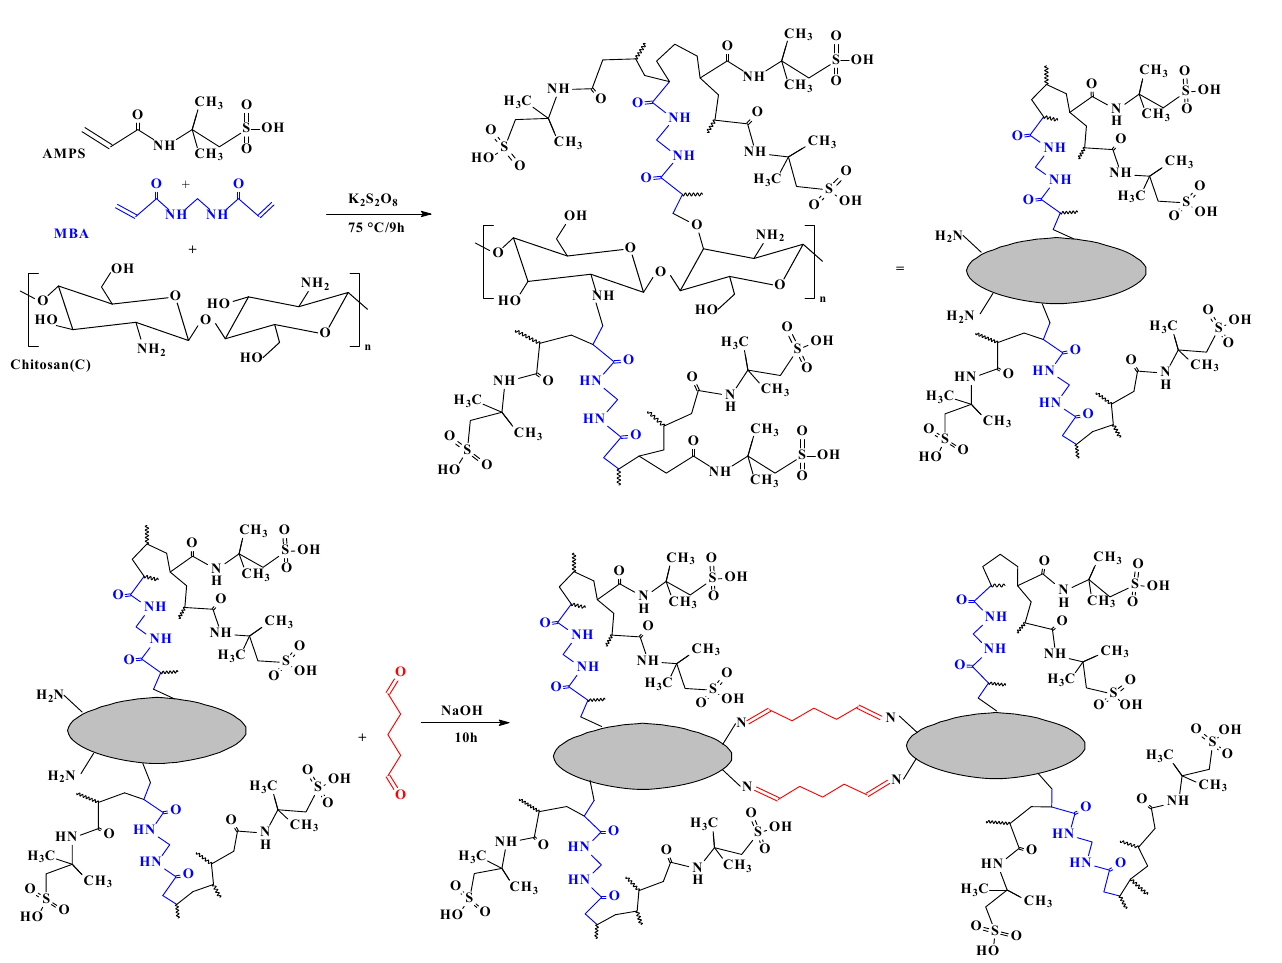
Scheme 2. Synthesis route of the sulfonic hydrogel (CH ‐